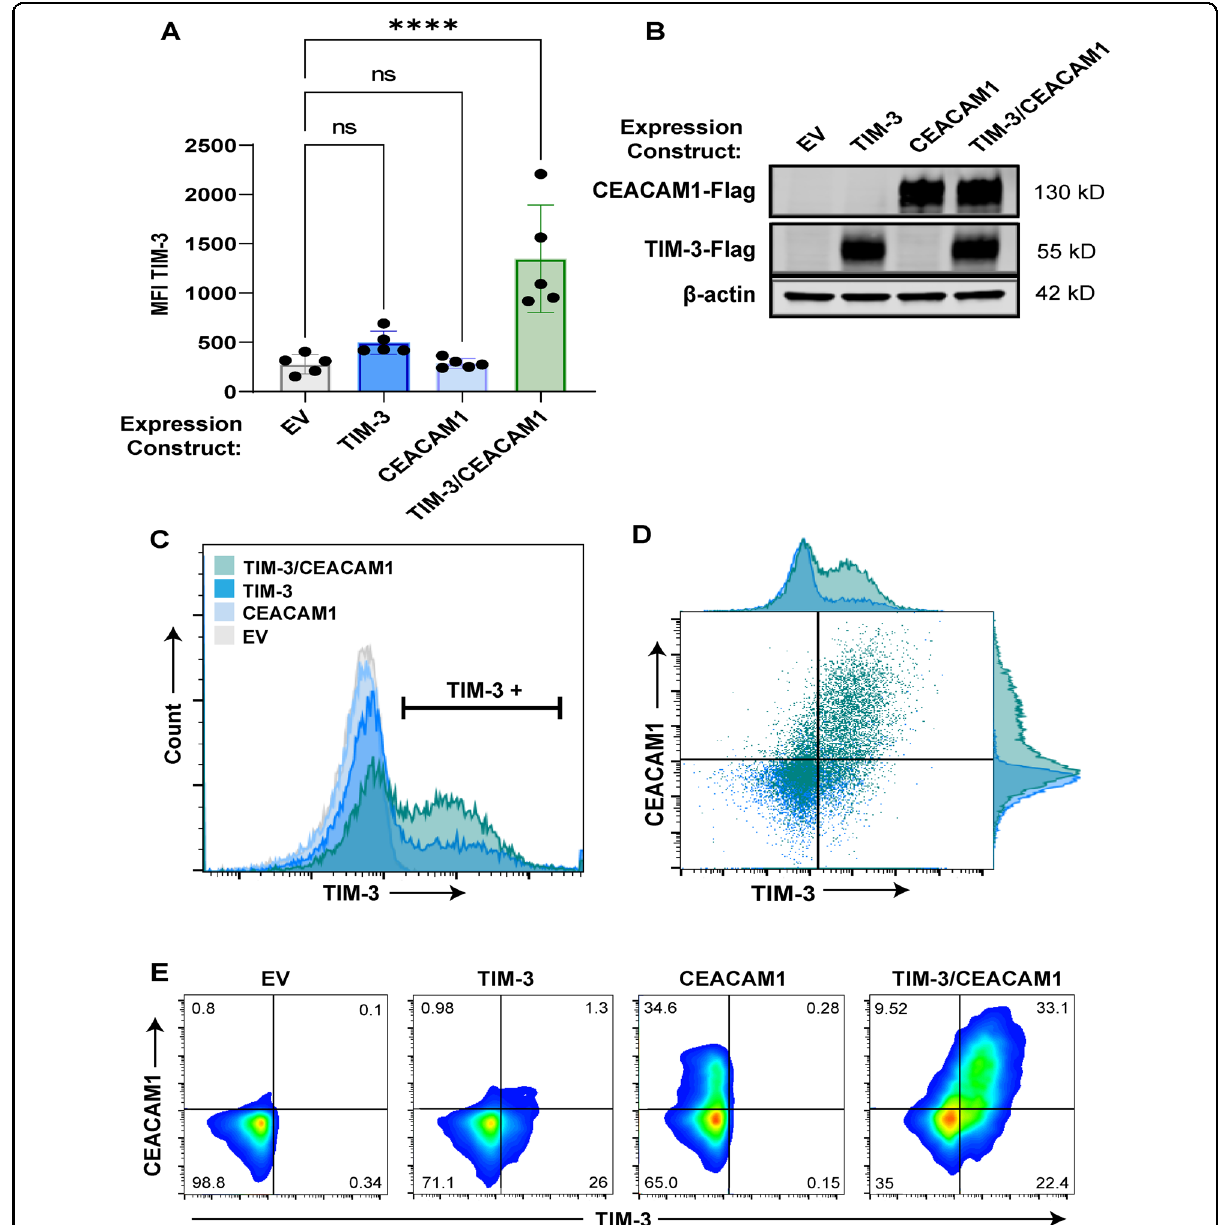
Fig. 5 Co-expression of CEACAM1 promotes TIM-3 surface expression on T cells. A Jurkat T cells were transfected with empty vector (EV), TIM-3, CEACAM1, or TIM-3 and CEACAM1 FLAG-tagged expression plasmids and assessed for TIM-3 surface expression. Each point represents separate experiments in which the median fl uorescence intensity (MFI) was assessed for each condition. Statistical tests: A one-way ANOVA with multiple comparisons; p < 0.0001 for EV against TIM-3/CEACAM1. B Cell lysates were assessed for total CEACAM1 and TIM-3 protein expression by western blot (anti-FLAG); β -actin served as a loading control. C Single experiment from (A) plotted as a histogram to highlight the increased % TIM-3 + cells with TIM-3 and CEACAM1 co-transfection. D Dot plot histogram overlay of Jurkats transfected with only TIM-3 (blue) versus both TIM-3 and CEACAM1 (teal). D Representative fl ow plots of Jurkats transfected as in ( A ).